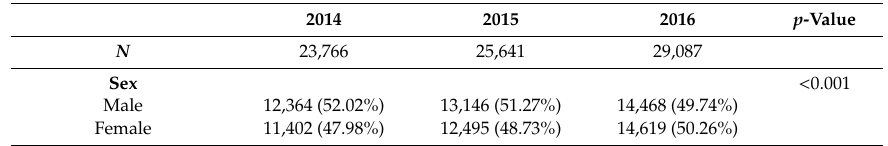
Table 1. Basic characteristics of cerebral infarction inpatients under the new rural cooperative medical system (NRCMS) in Dingyuan and Funan County,